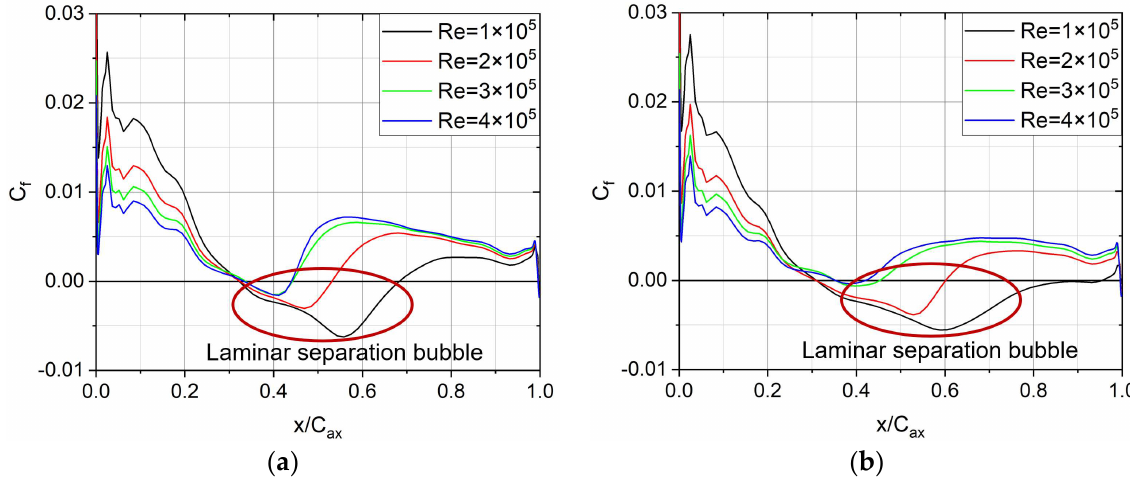
Figure 11. Comparison of skin friction coefficient and the region of laminar separation bubble on the suction surface at 50% span. ( a ) Without wake; ( b ) with wake.